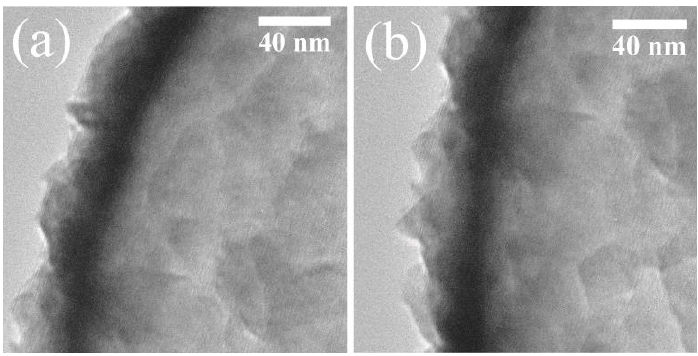
Figure 4. High magnification TEM images of the surface of ( a ) HCSs and ( b ) NHCSs.